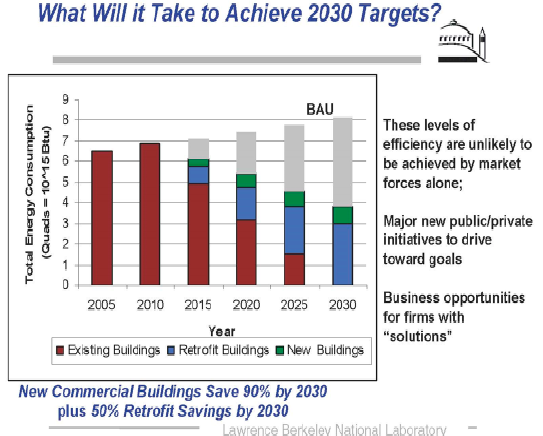
Figure 8. The need for retrofitting existing buildings. Reprinted with permission of Lawrence Berkeley National